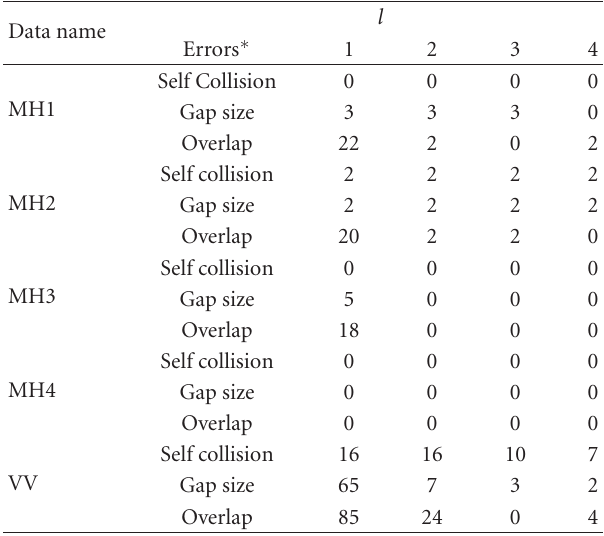
Table 3: Number of reported errors in sca ff old construction for 5 dataset.